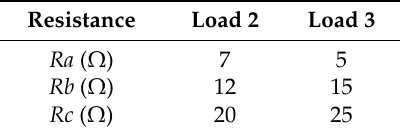
Table 1. Load 2 and 3 values (see Figure 5).